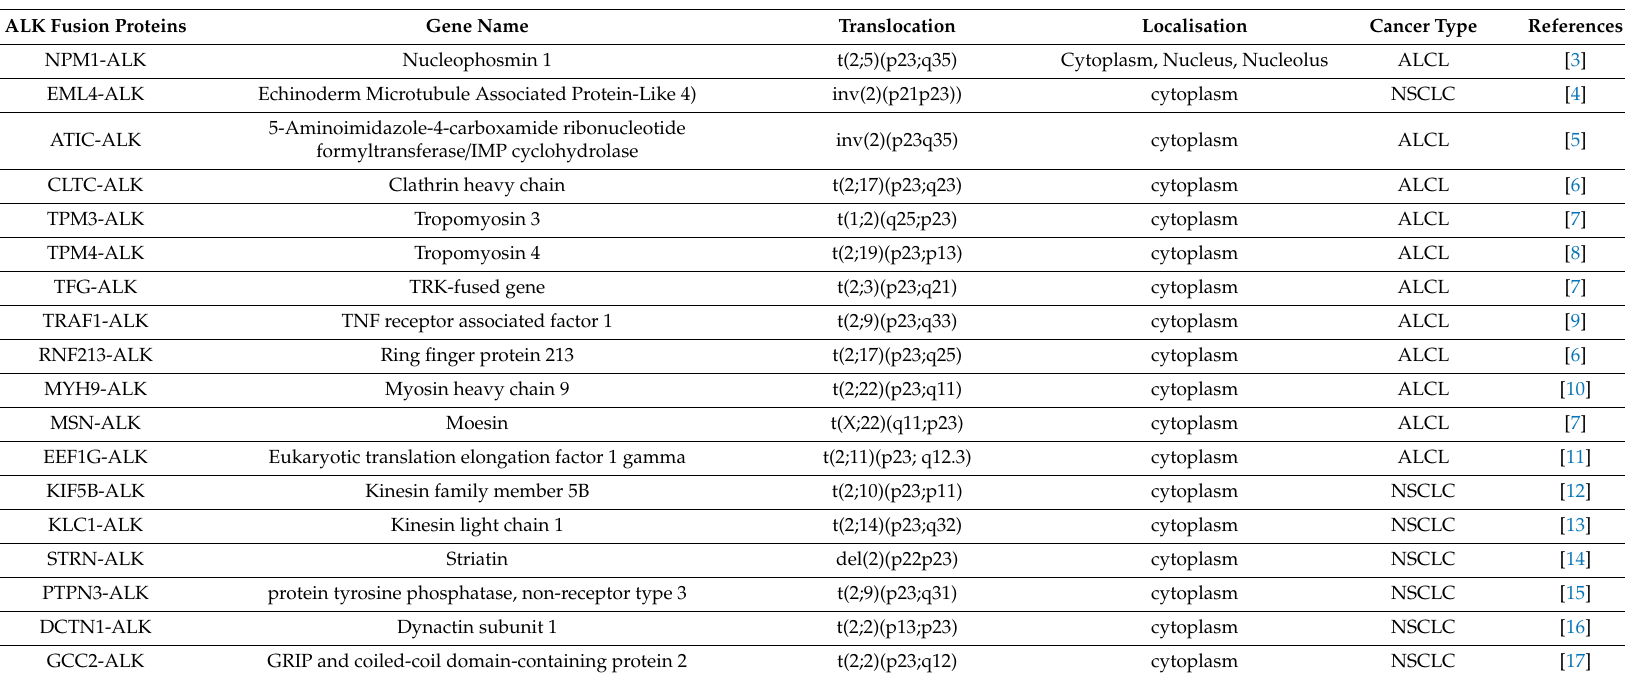
Table 1. An assortment of anaplastic lymphoma kinase (ALK) fusion proteins have been described in anaplastic large cell lymphoma (ALCL) and non-small cell lung carcinoma